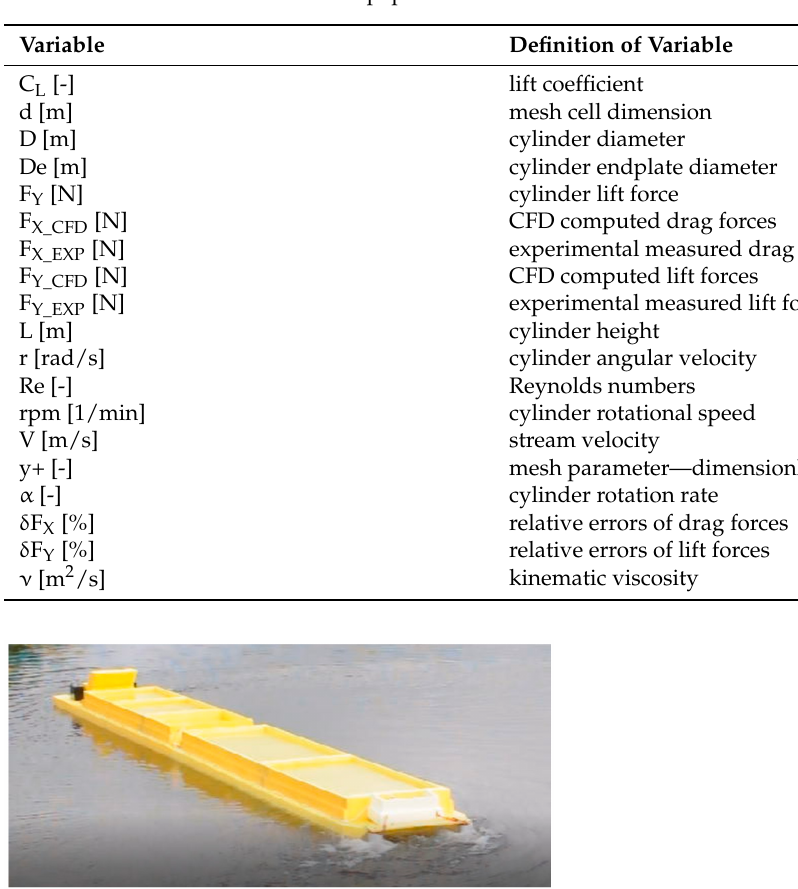
Table 1. List of variables used in the paper.